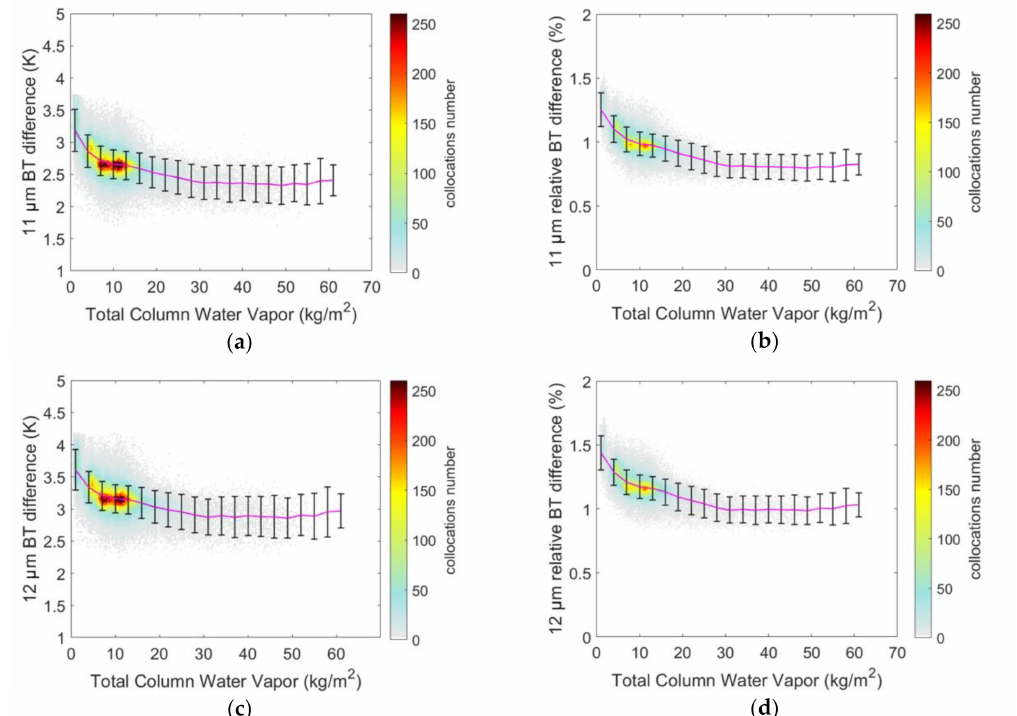
Figure 9. The variations in ( a ) the 11 µ m COCTS minus IASI BT difference, ( b ) the 11 µ m COCTS minus IASI relative BT difference, ( c ) the 12 µ m COCTS minus IASI BT difference, and ( d ) the 12 µ m COCTS minus IASI relative BT difference against the total column water vapor